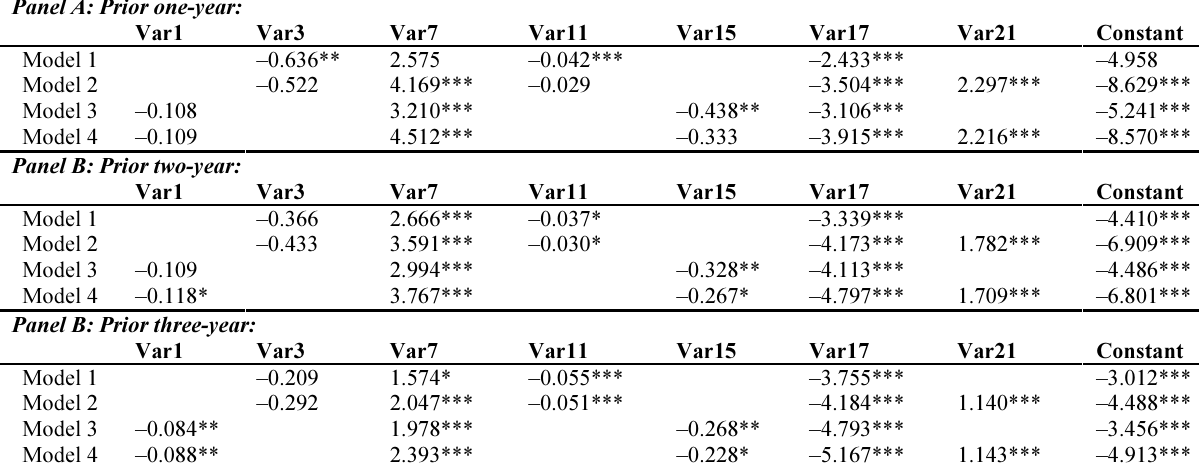
Table 6. The coefficient estimates for the logit regressions